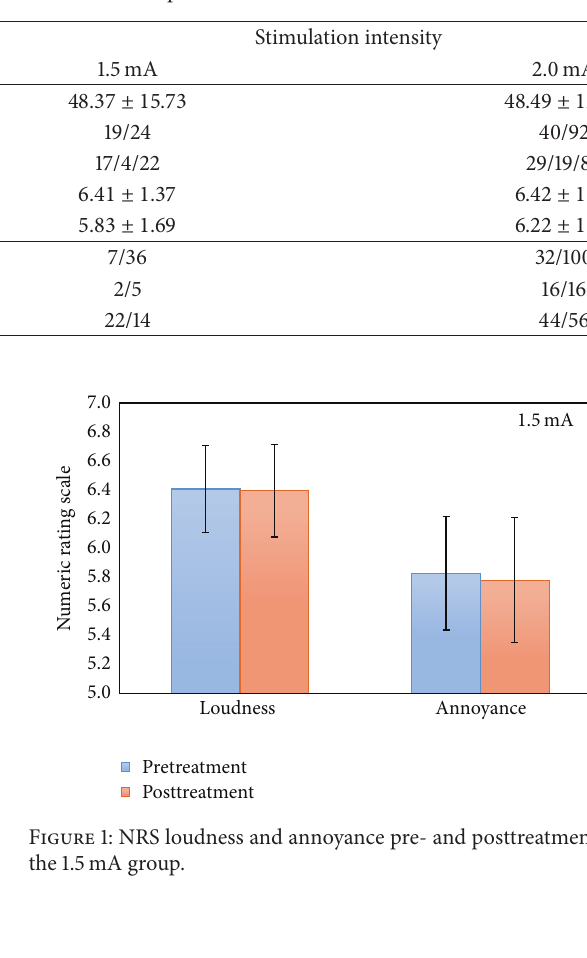
Table 1: Patient characteristics and stimulation parameters.